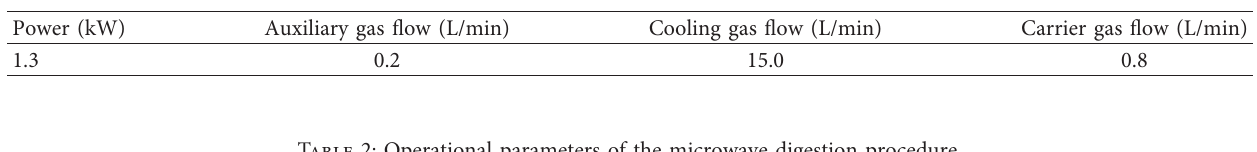
Table 1: ICP-AES operating